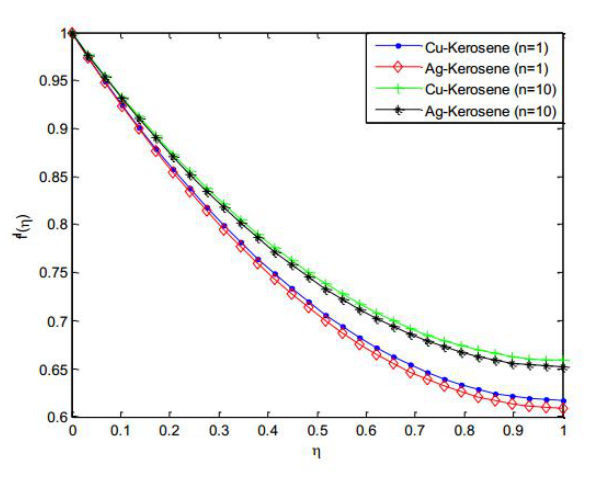
Figure 14. Effect of power-law index on the fluid velocity distribution